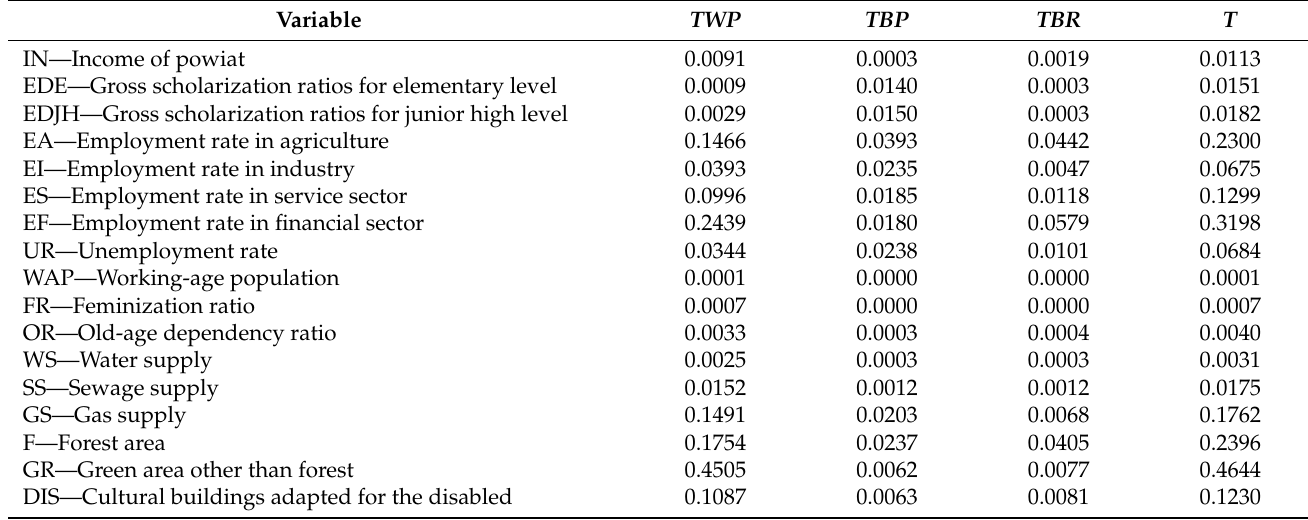
Table 6. National overall and component inequality of socioeconomic determinants of health distribution.